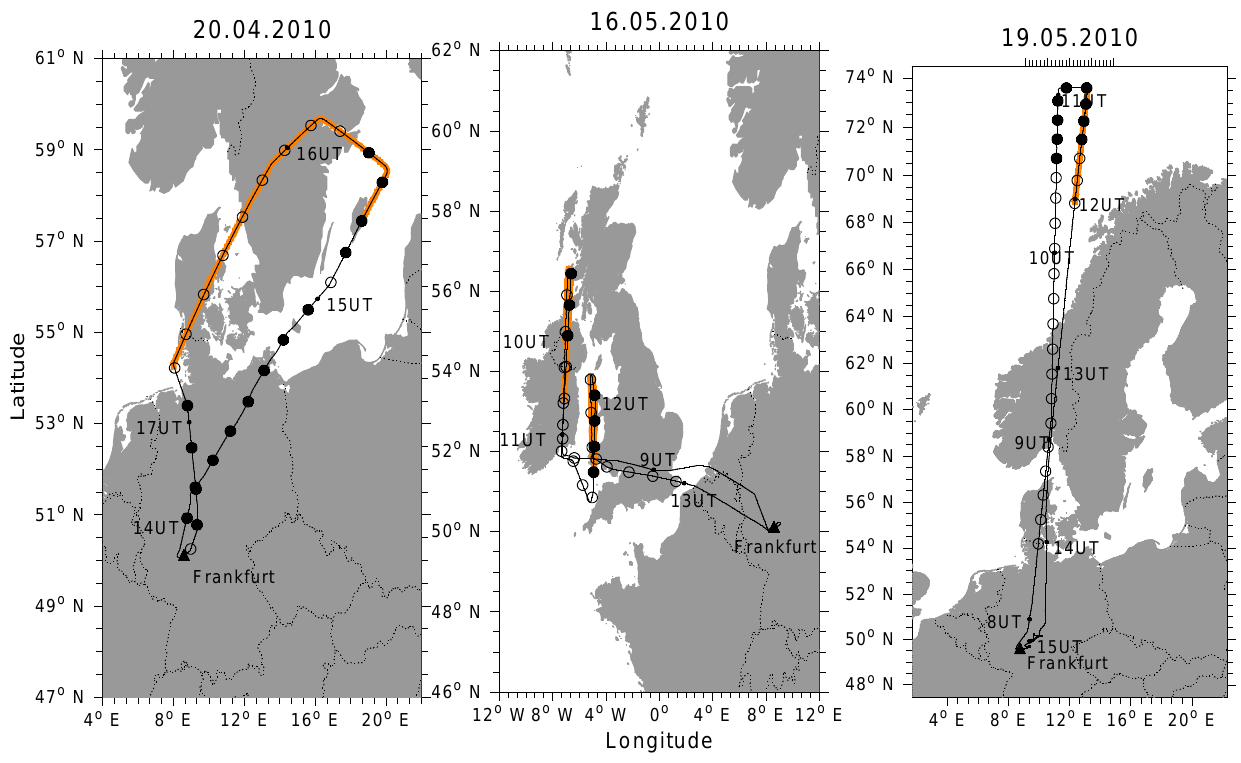
Fig. 1. Flight tracks of the CARIBIC flights on 20 April 2010 (left), 16 May 2010 (middle) and 19 May 2010 (right) with indicated flight times. Circles mark the whole air glass flask sample locations where solid circles denote those samples that have a volcanic influence (as determined from the whole air samples and the backward trajectories). The orange highlighted segments of the flight tracks mark the integration times of those aerosol impactor samples which indicated volcanic origin of the sampled particles. Note the different geographical projection of the right map. Table 1. Complex refractive index and density for an internal mixture of aerosol particles, based on volume mixing rules. The given volume fractions assume “typical” aerosol composition for those atmospheric regions where most of the CARIBIC measurements were conducted. The refractive indices for the different aerosol compounds are taken from Toon et al. (1976), Hummel et al. (1988), Krekov (1993), Bond and Bergstrom (2006) and Dick et al. (2007). Mixed complex refractive index and particle density are calculated using volume mixing rules. Composition Mixed complex Mixed particle Region [volume